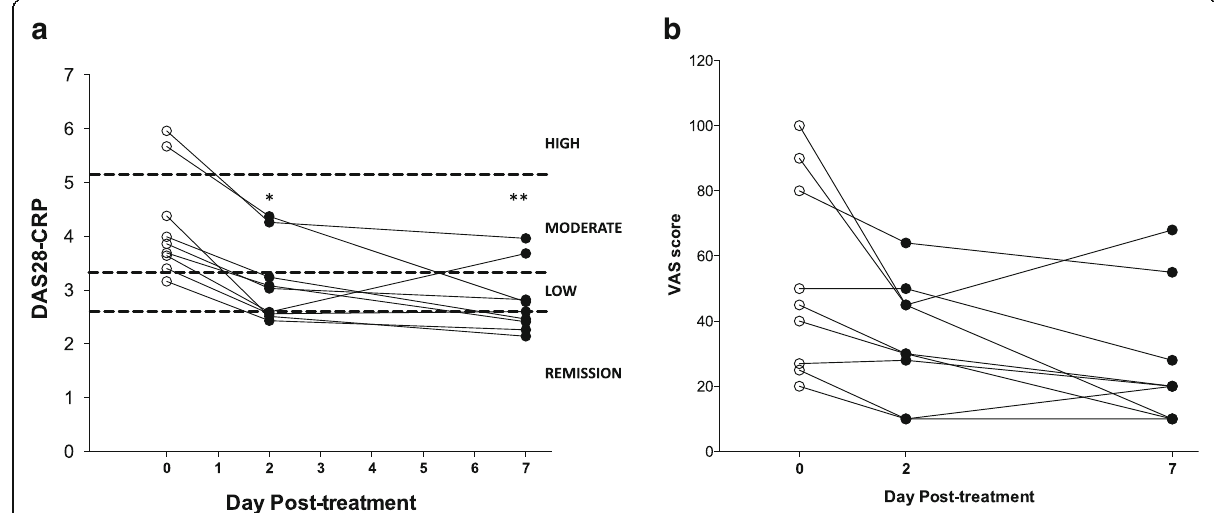
Fig. 5 The effect of vibrotactile treatment at the cymba concha in patients with rheumatoid arthritis. ( a ) The DAS28-CRP scores, ( b ) The visual analog scores in nine RA patients enrolled in the prospective interventional study. DAS28-CRP scores indicate a composite score of enumeration of swollen and tender joints, measurement of high-sensitivity CRP in serum, and scores on the visual analog scale, a validated patient-reported assessment of functional status and well-being. These data were obtained at day 0 (pre-treatment), day 2 and day 7 (post-treatment) following vibrotactile treatment at the cymba concha. Lines connect data points for the DAS28-CRP score of each individual study participant at these timepoints. Hashed lines indicate the cut-off points for categories of disease severity. A DAS score of less than 2.6 indicates remission; a score between 2.6 and 3.2 indicates low/minimal disease activity; a score between 3.2 and 5.1 indicates moderate activity; a score of more than 5.1 is considered high/severe disease activity (Fransen and van Riel 2009; Anderson et al. 2012). The significance of the change by RMANOVA using Friedman test between visits is shown: * p < 0.05 vs. day 0; ** p < 0.01 vs. day